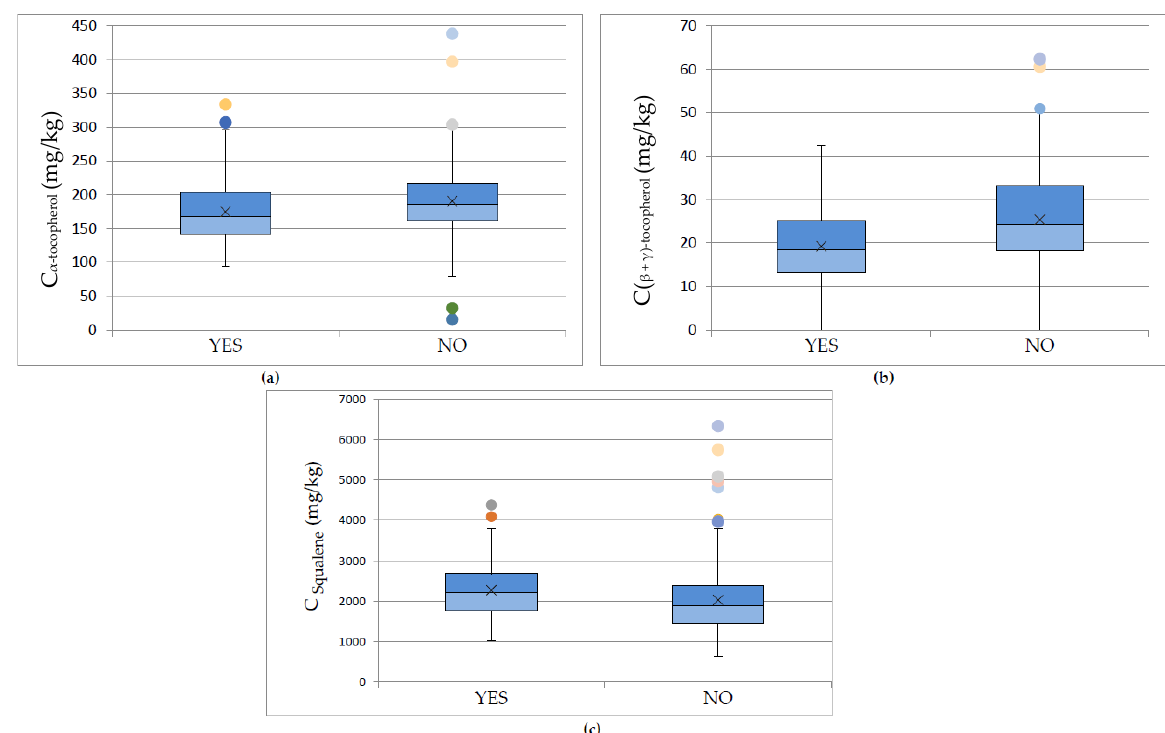
Figure 6. Box and whisker plots presenting the concentration of ( a ) α -tocopherol, ( b ) ( β + γ )-tocopherols, and ( c ) squalene regarding to the addition of water during malaxation. YES ( n = 120 samples), NO ( n = 209 samples).